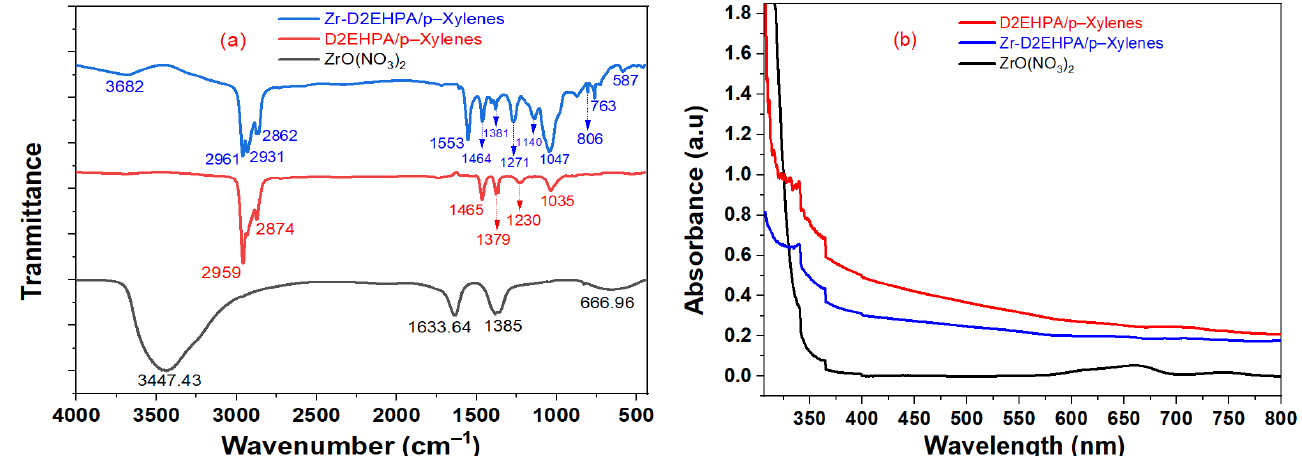
Figure 2. ( a ) FT ‐ IR spectra and ( b ) UV ‐ Vis spectra of ZrO(NO 3 ) 2 ; D2EHPA/p ‐ xylenes; and Zr–D2EHPA/p ‐ xylenes.